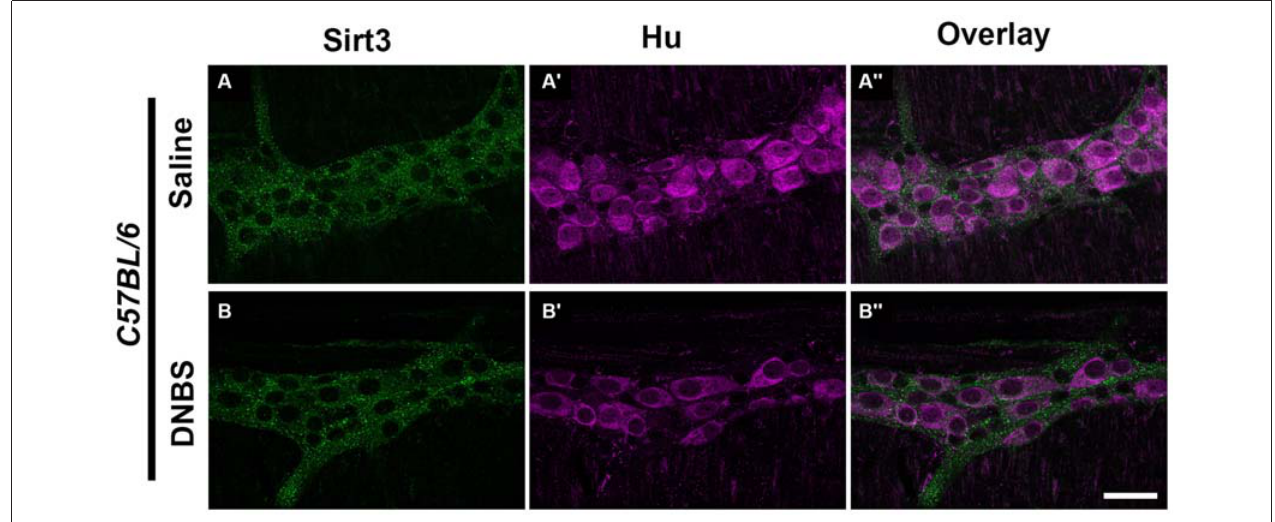
FIGURE 5 | Sirt3 expression in healthy and inflamed C57BL/6 mice . Panels show confocal fluorescence microscopy images of dual-label immunohistochemistry for Sirt3 (green, A,B ) and the neuronal marker HuC/D (magenta, A’,B’ ). Overlays of each combination are shown in (A”,B”) . The scale bar in panel B” = 50 µ m and applies to (A–B”) . Labeling is representative of experiments performed on tissue from a minimum of four